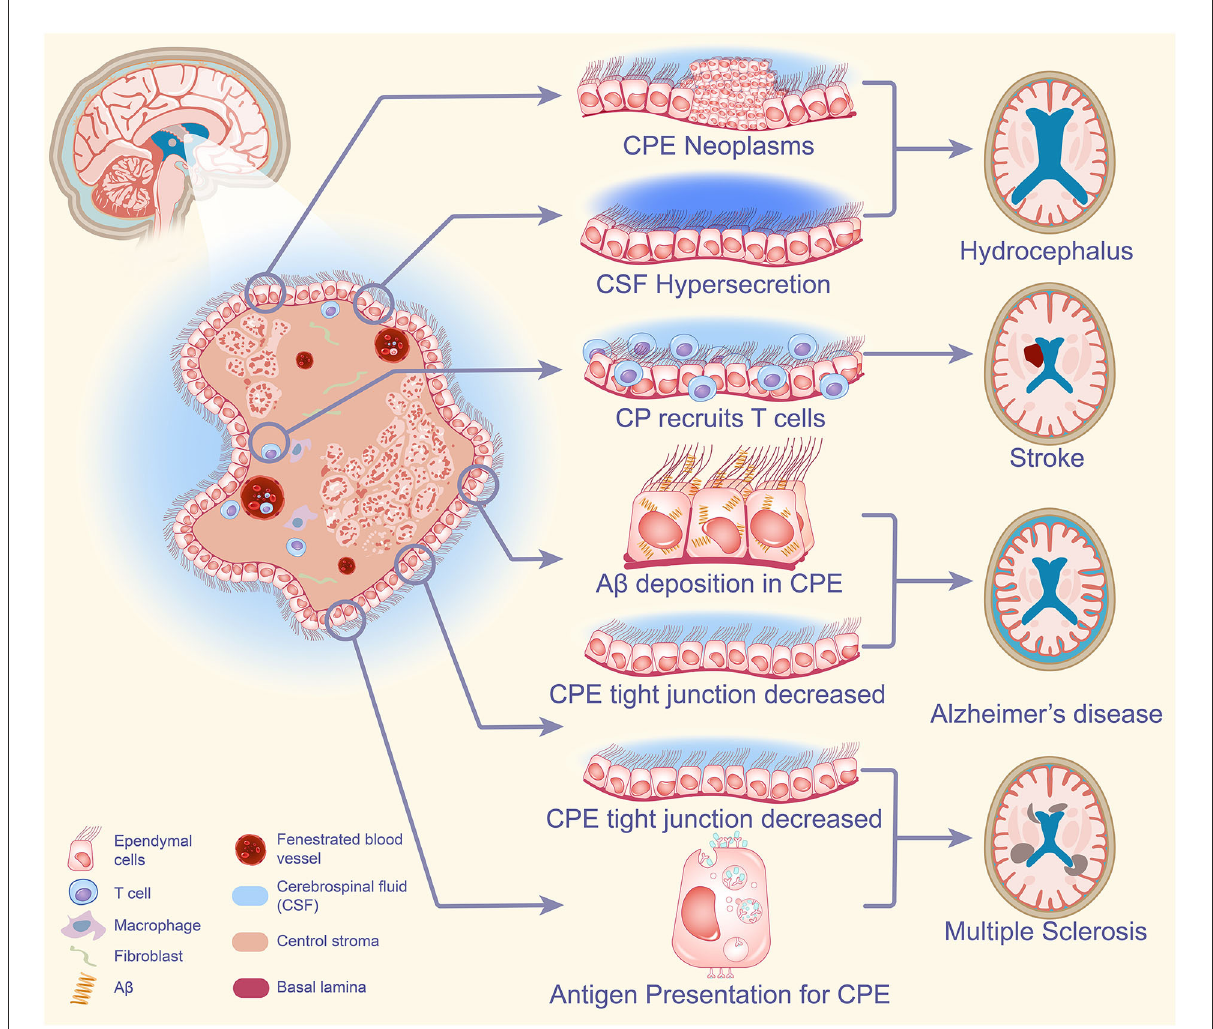
FIGURE2 CPE-based neurological pathogenesis. When CPE tumors are present in the brain, excessive CSF secretion can have a great impact on the normal absorption and excretion of CSF, CSF circulation, and ultimately the development of hydrocephalus. The CPE is involved in the accumulation of inflammatory cells in the brain after stroke and plays an important role in the destruction of brain mechanisms by post-stroke inflammation. Increased A β deposition in CPE blocks the secretion of CSF, and the small flow of CSF significantly reduces the clearance of A β protein deposition in AD, while the reduction of tight junctions in CPE increases the permeability of blood cerebrospinal fluid, causing an increase in the degree of chronic neuritis, leading to the development of AD. Under the influence of peripheral neuroinflammation, the CPE changes and cellular tight junctions decrease, resulting in increased permeability of BCSFB and accelerated entry of inflammatory cells such as leukocytes into the brain to accelerate their injury. The CPE is also involved in the immune response process including antigen presentation and plays an important role in the pathogenesis of MS. CPE, choroid plexus epithelium; CSF, cerebrospinal fluid; A β , amyloid- β ; AD, Alzheimer’s disease; BCSFB, blood-cerebrospinal fluid barrier; MS, multiple